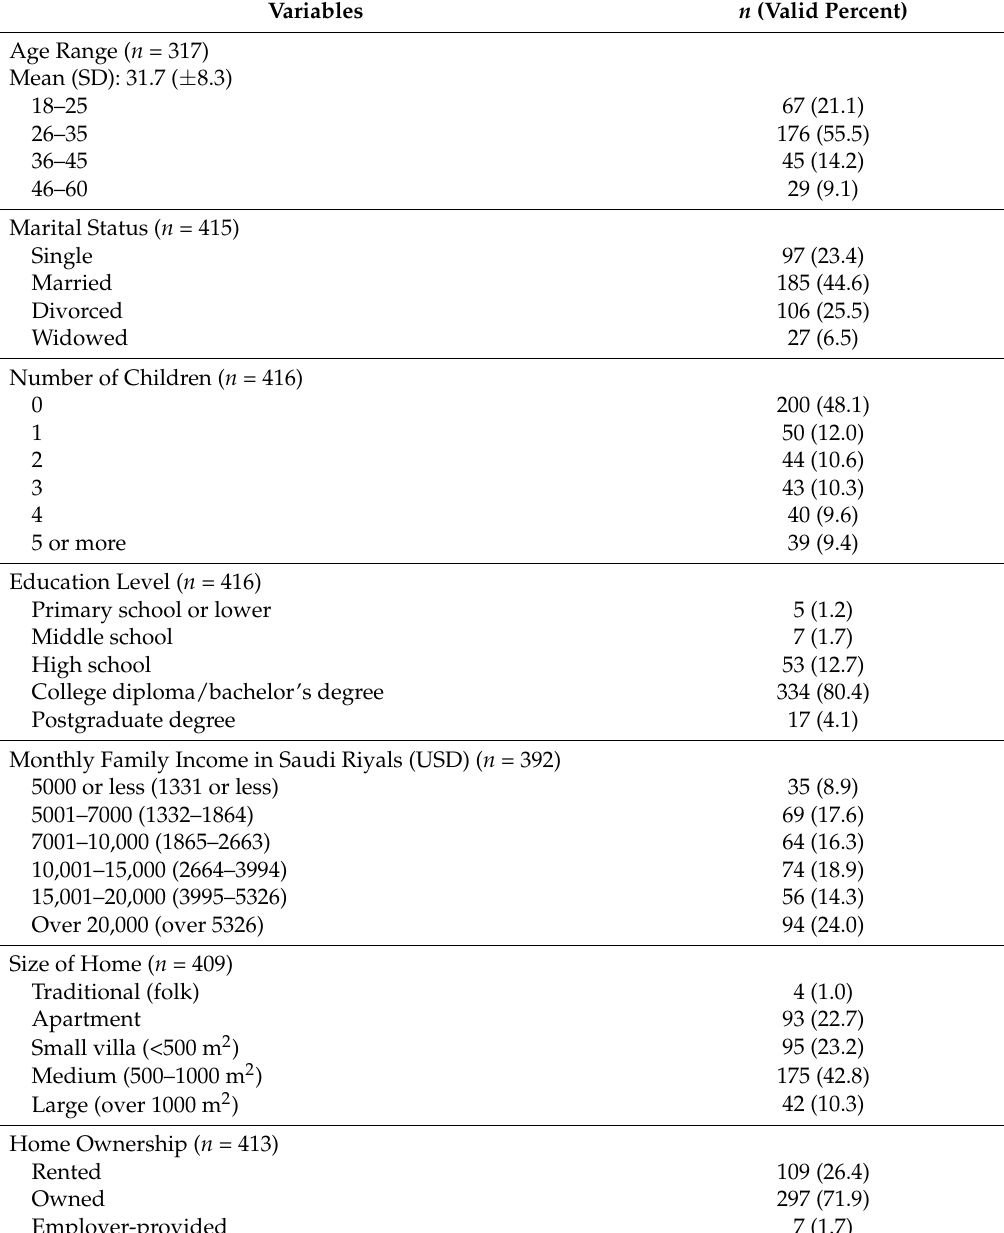
Table 1. Demographic variables among the sample of Saudi female employees ( n =